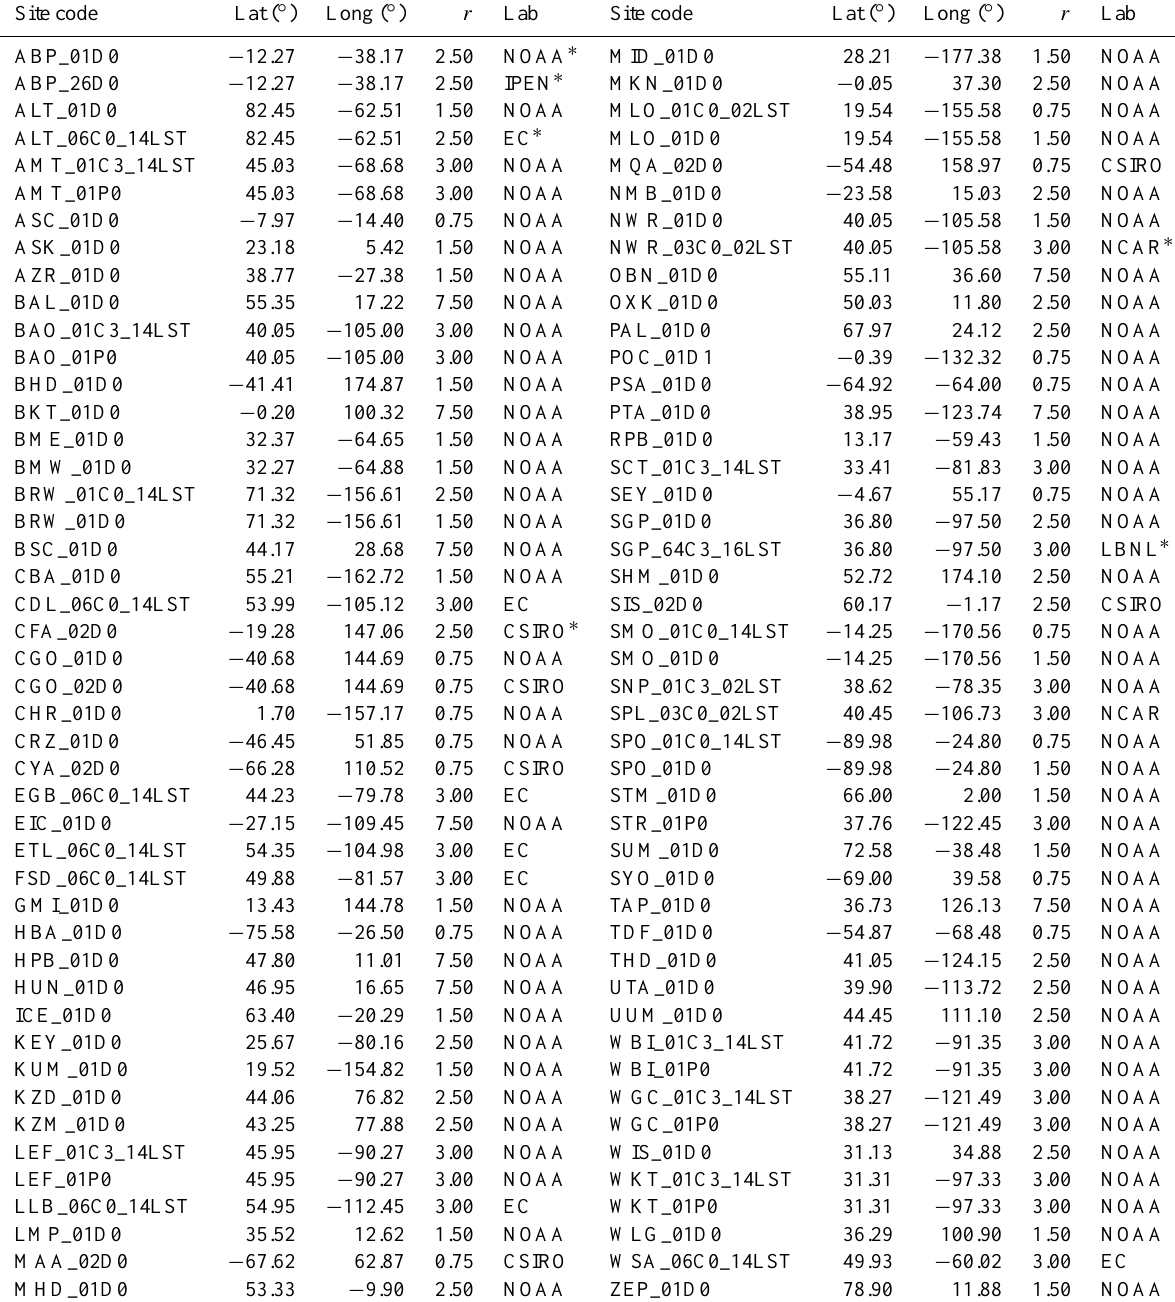
Table 1. Listed are 92 observation sites used in this study. r refers to prescribed observation error (µmolµmol − 1 ) . Site